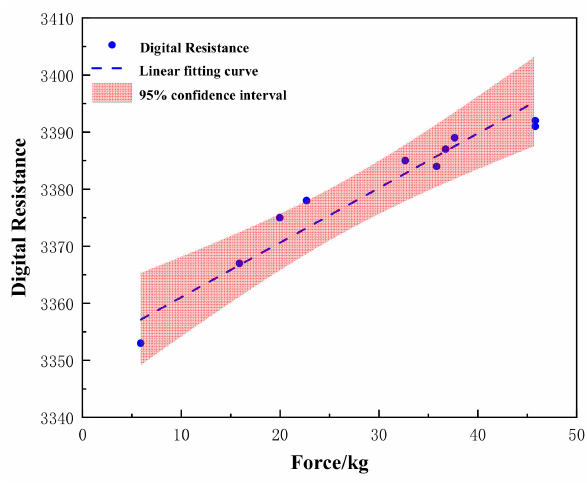
Figure 16. Relationship between digital resistance and